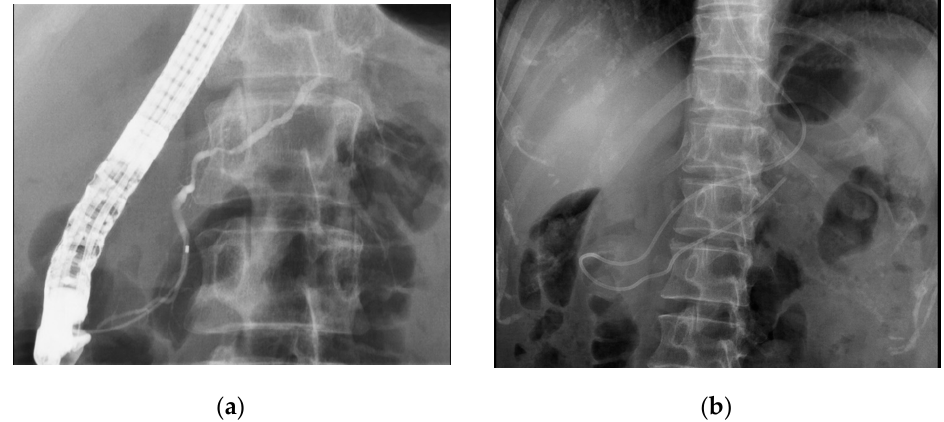
Figure 4. Pancreatic juice cytology. The guidewire was inserted to the stenosis of the pancreas duct through an ERCP ( a ). Then the wire remains and the ENPD catheter is placed into the pancreas duct ( b ). Pancreatic juice can be collected from an ENPD tube up to six times for 1 day.